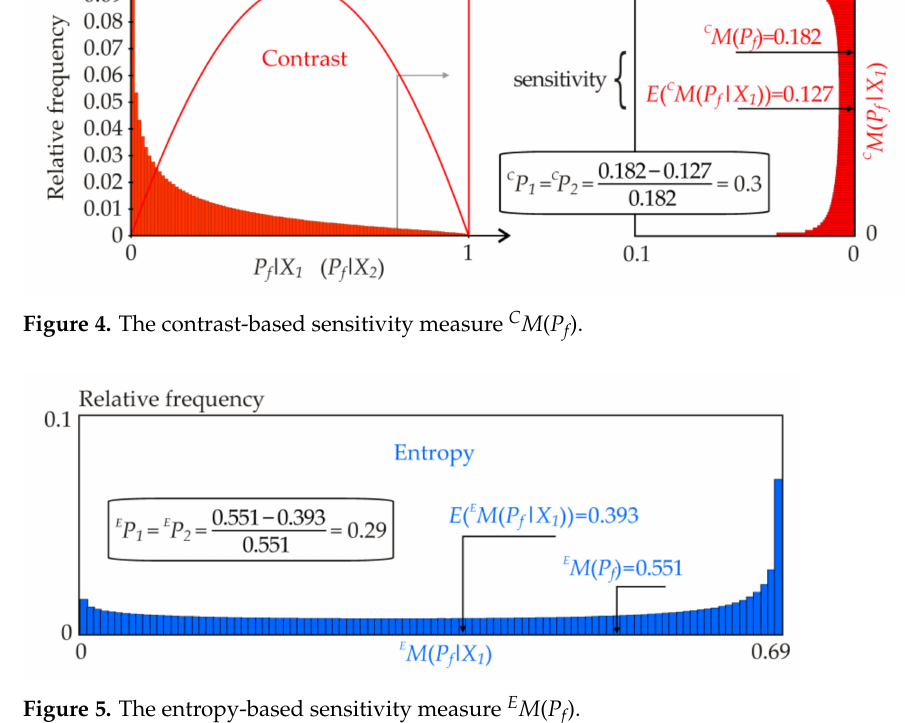
Figure 5. The entropy-based sensitivity measure E M ( P f